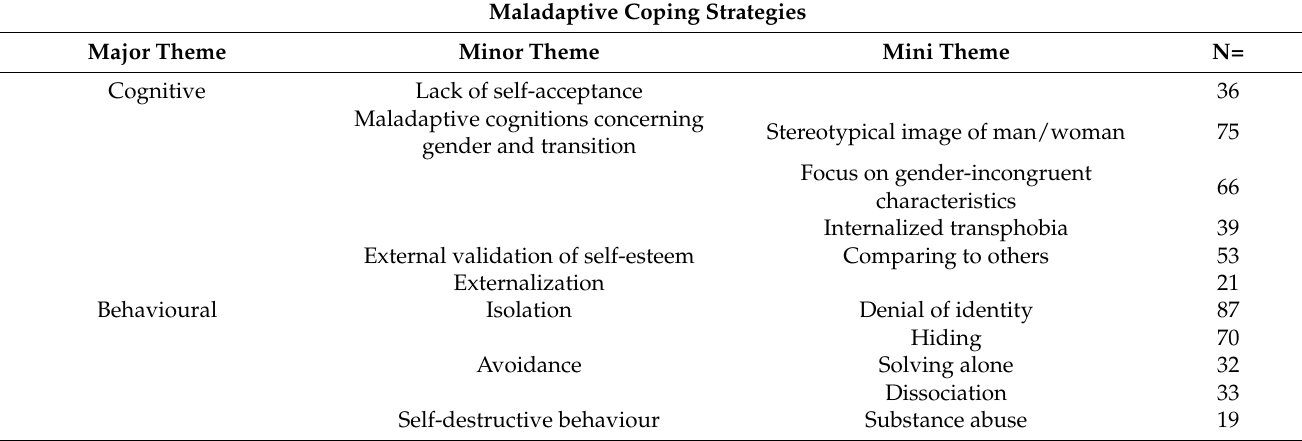
Table 4. Maladaptive coping strategies. Maladaptive Coping